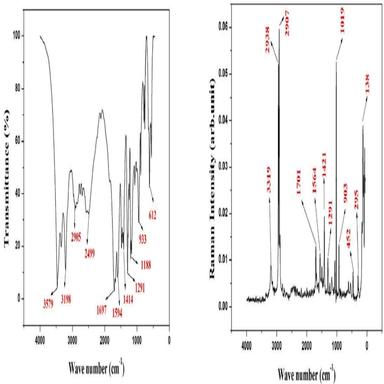
FT-IR and FT – RAMAN spectrum of UGA.